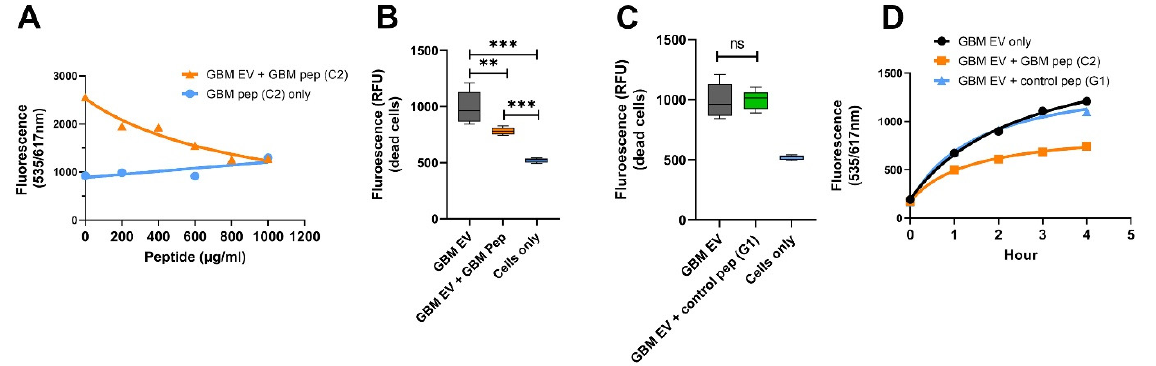
Figure 6. GBM EV-specific peptides inhibit neuronal cytotoxicity induced by the GBM EVs. ( A ). GBM EV-specific peptide inhibits EV-induced neuronal cytotoxicity in a dose-dependent manner. SH-SY5Y cells were incubated with GBM pooled plasma EVs at 20 mg/mL plus 5% Normal Human Serum. GBM EV-specific peptide C2 in various amounts was added to cells at the same time as the EV treatment. Cell death was monitored by ethidium homodimer-1 (red fluorescent reading). With 1000 mg/mL peptide, the GBM EV peptide nearly completely blocked the GBM-EV cytotoxicity after 4-h treatment. Cells with peptides (C2) alone did not produce cytotoxicity. ( B , C ). GBM EV-specific peptides ( B ), but not the control peptides ( C ) show time-dependent inhibition of EV induced neuronal death. Neuroblastoma SH-SY5Y cells were treated with GBM EVs plus peptides, and cytotoxicity was monitored for 4 h. GBM EV-specific peptide C2 inhibited GBM-EV induced cytotoxicity (GBM EV + GBM Pep), but not the control peptide to HC EV (G1) (GBM EV + control pep G1) (** p < 0.01, *** p < 0.001). ( D ) Time course of GBM-C2 peptide for the inhibition of GBM-EV cytotoxicity. SH-SY5Y cells were treated with GBM EVs at 20 mg/mL plus 5% Normal Human Serum. The GBM-C2 peptide (1000 mg/mL) or the HC-G1 peptide (as control, 1000 mg/mL) was added to cells during the same time as EV treatment. The cell death was monitored by propidium iodide red fluorescent reading once per hour. Results showed that the GBM peptide can inhibit GBM EV-induced cell death.